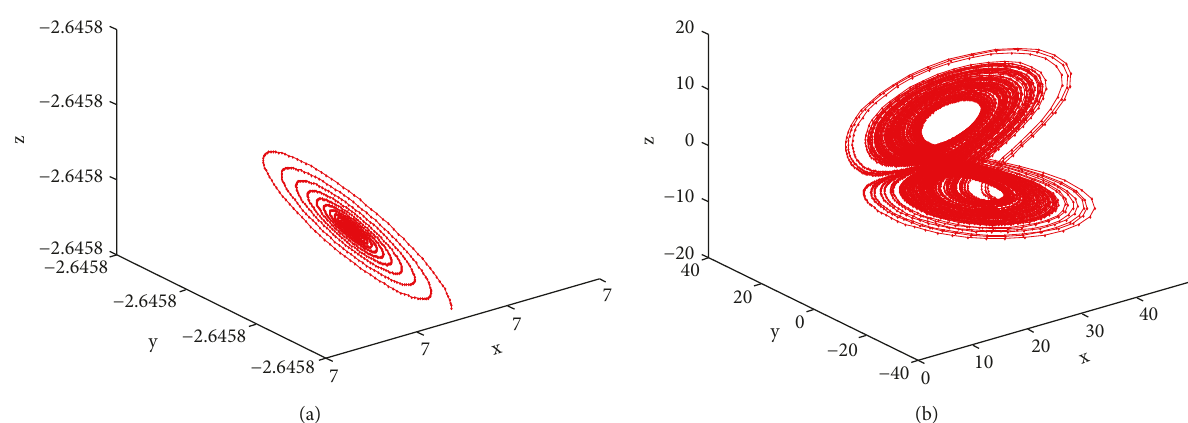
Figure 4: The phase diagrams of system (2) with b , δ = 3, 0 02 : (a) a = 8 and (b) a = 28 .